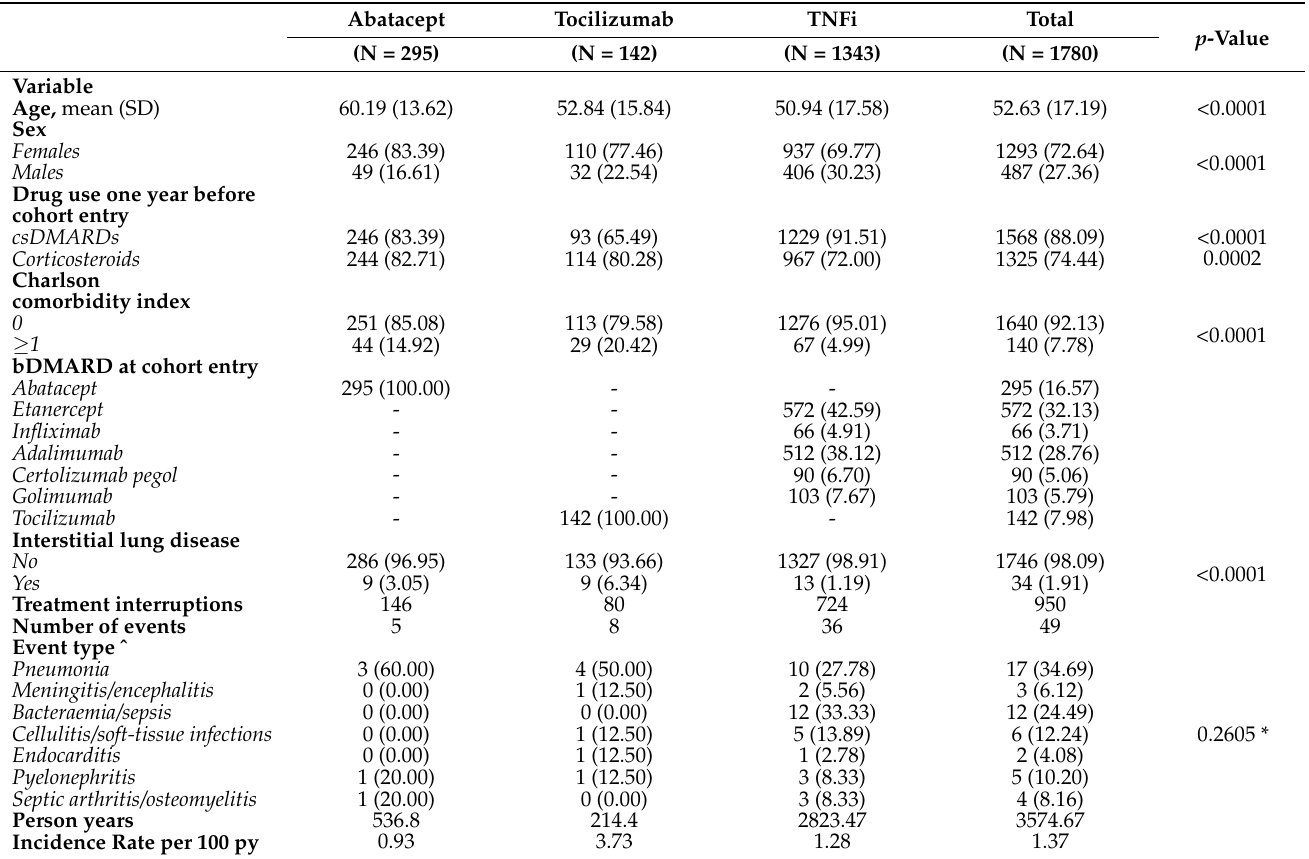
Table 1. Distribution of subjects’ characteristics according to biological disease-modifying anti- rheumatic drugs (bDMARD) used at cohort entry.